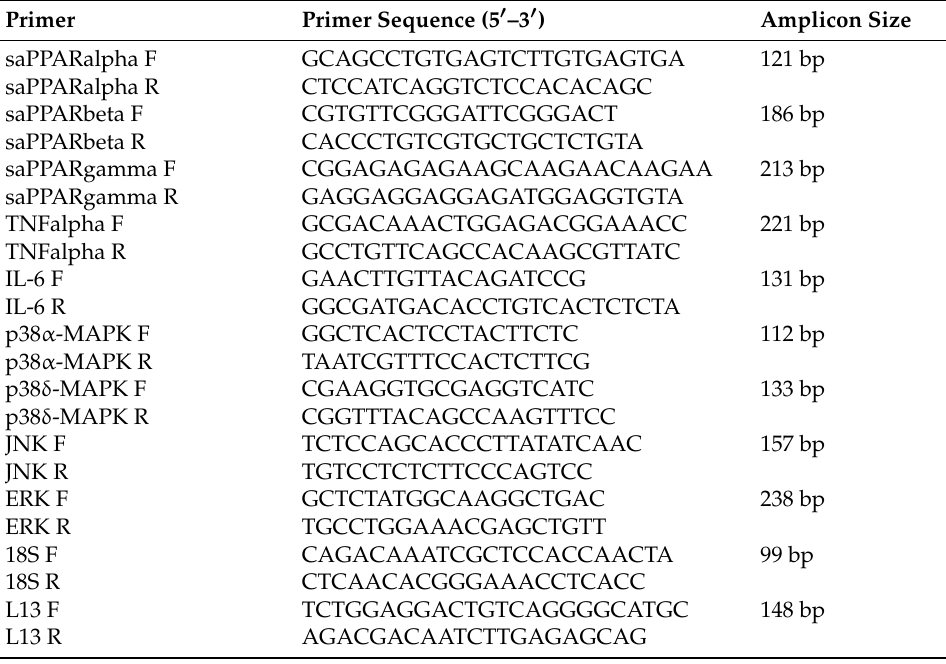
Table 1. Sequences of primers used in gene expression analyses by